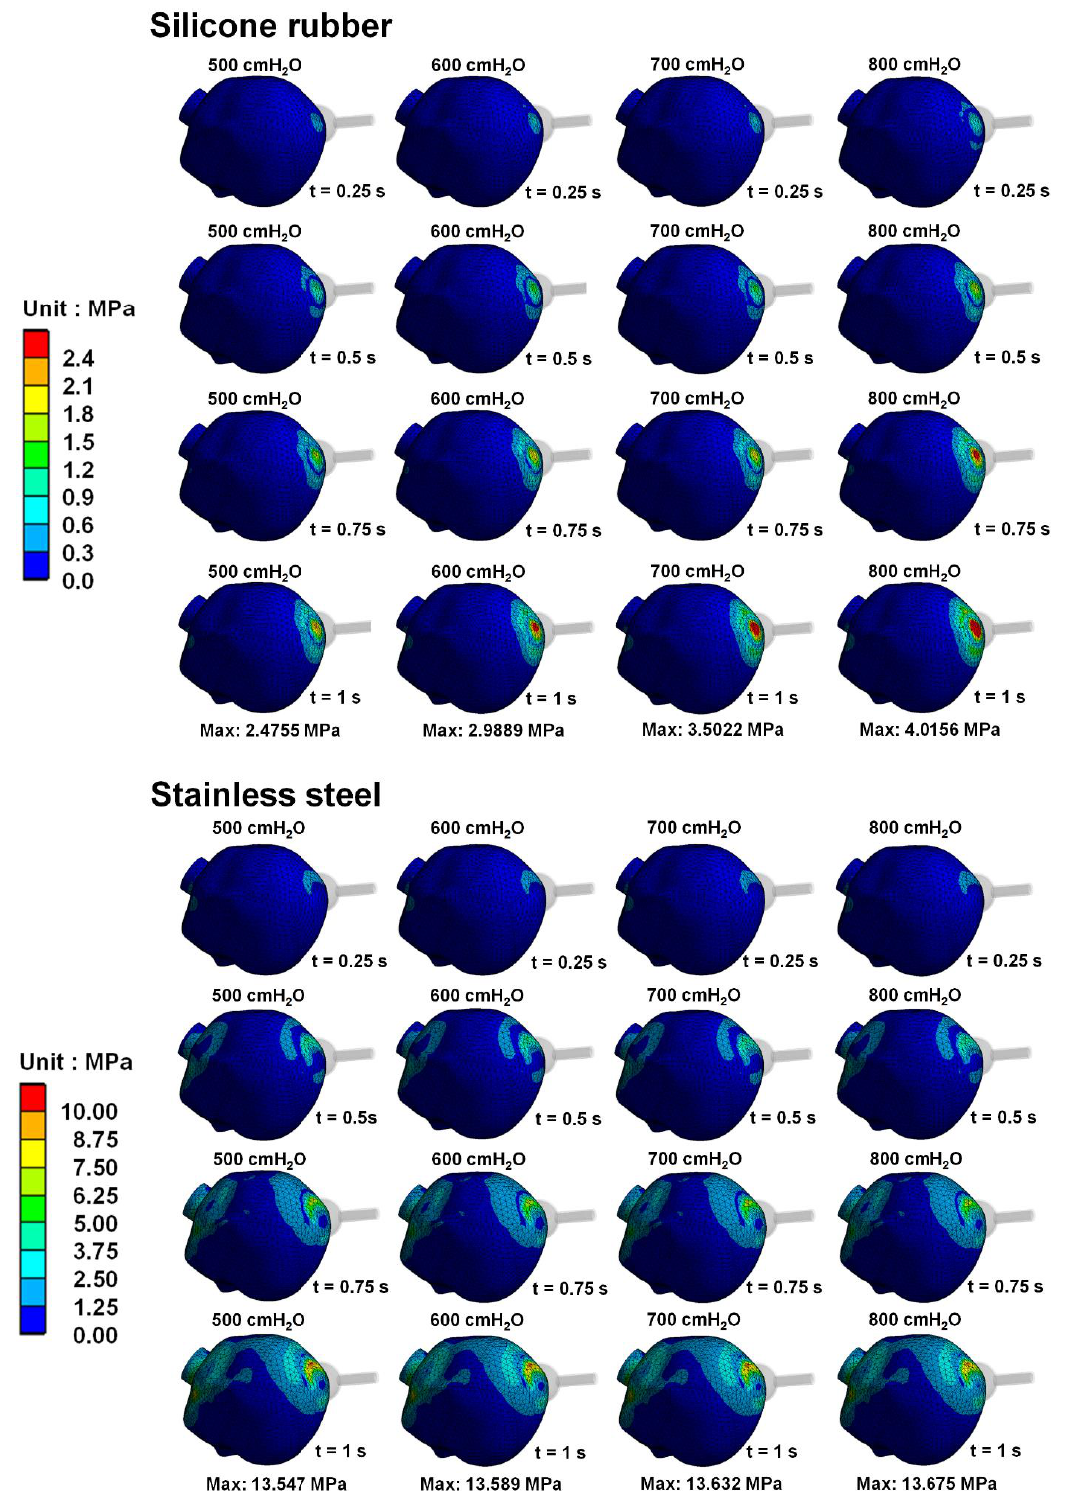
Figure 7. Distribution of von Mises stress on the skull measured under different vacuum extractor materials and pressures at different times.